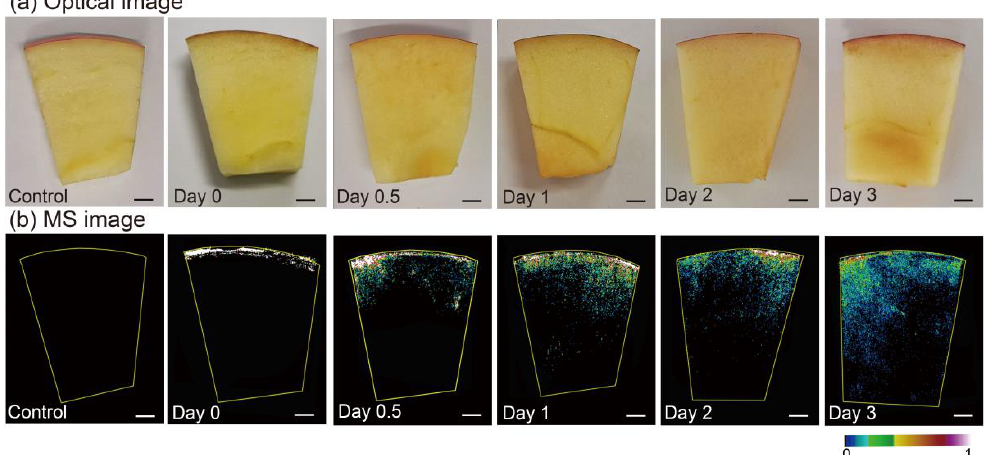
Figure 3. ( a ) Optical images and ( b ) the corresponding MS images of chlorantraniliprole in apple slices without chlorantraniliprole application and with 0, 0.5, 1, 2, and 3 days after chlorantraniliprole spraying. Scale bar of 4 mm.